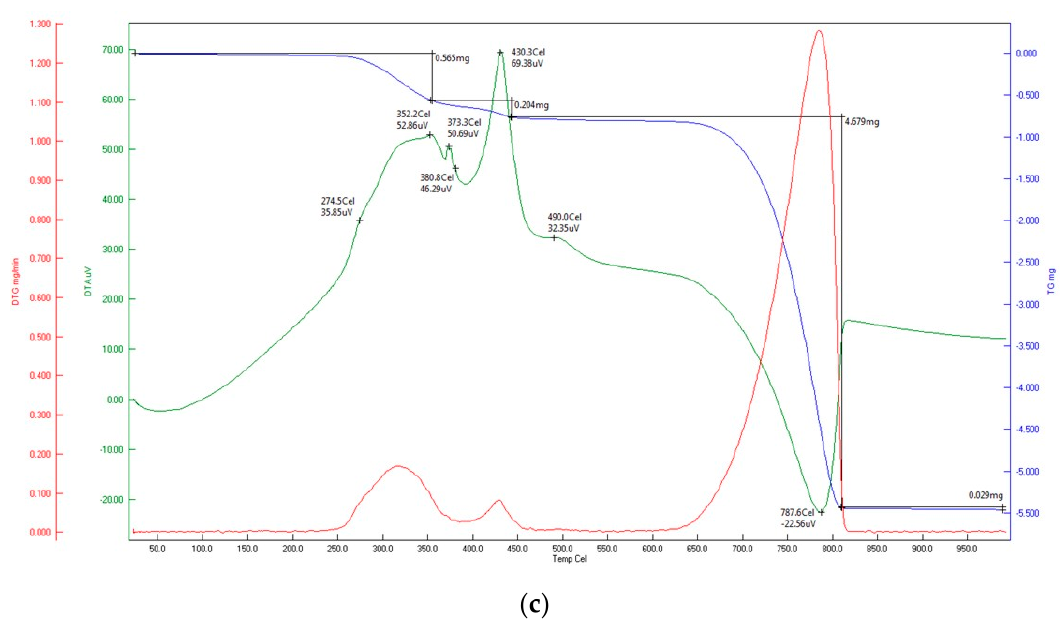
Figure 3. Results of TGA analysis: ( a ) sample A, ( b ) sample B, ( c ) sample C.